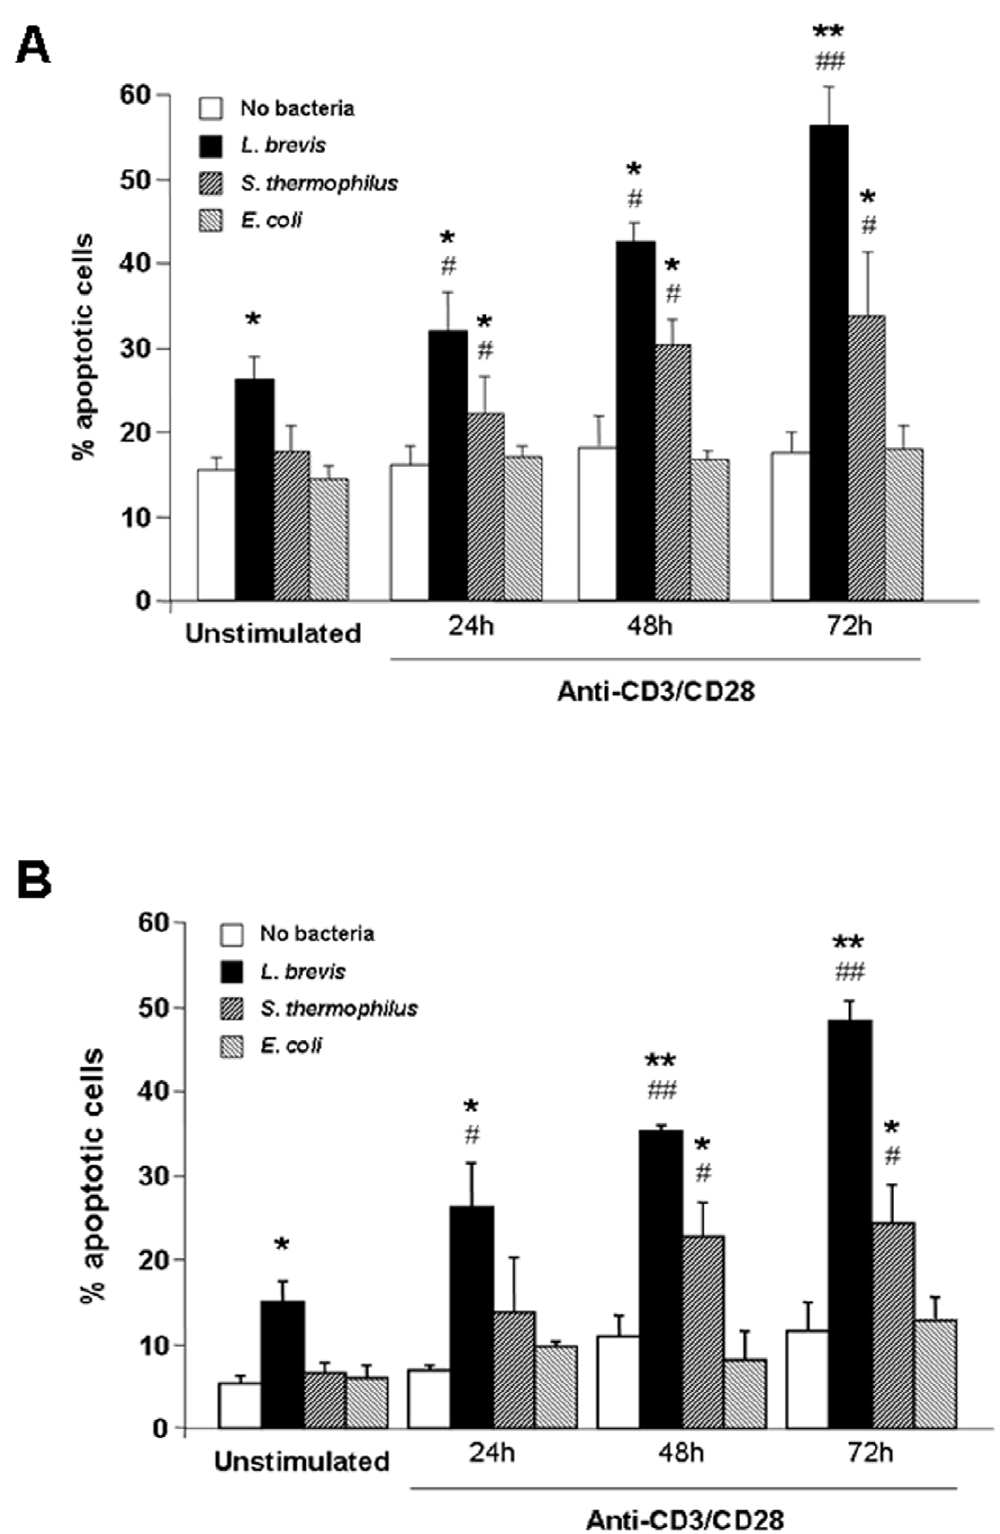
Figure 3. Effect of cell activation on probiotic-induced mononuclear cell apoptosis. A) Control LPMC were left untreated or activated with combined anti-CD3/CD28 for 24, 48 or 72 hours. Subsequently, cells were exposed to L. brevis , S. thermophilus , or E. coli sonicates for 24 hours, after which the percentage of apoptotic cells was assessed. Each bar represents 4 separate experiments. * p , 0.01 and ** p , 0.001 vs. no bacteria; # p , 0.05 and ## p , 0.01 vs. unstimulated LPMC. B) Control PBMC were left untreated or activated with combined anti-CD3/CD28 for 24, 48 or 72 hours. Subsequently, cells were exposed to L. brevis , S. thermophilus , or E. coli sonicates for24 hours, after whichthepercentage of apoptotic cells wasassessed. Each bar represents 4 separate experiments. * p , 0.01 and ** p , 0.001 vs. no bacteria; # p , 0.05 and ## p , 0.01 vs. unstimulated PBMC.